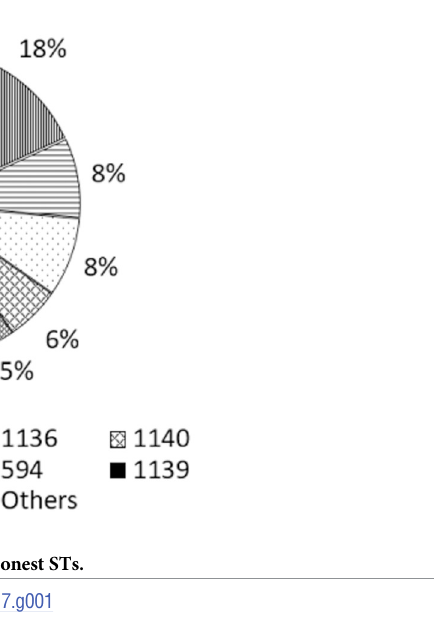
factor was diabetes (64%, n = 199). Percentage distribution of STs (n = 193) is shown Fig 1. Culture positive melioidosis cases per 100,000 population for each of the nine provinces is shown in Table 1. Genotyping and analyses were performed as shown in Fig 2.